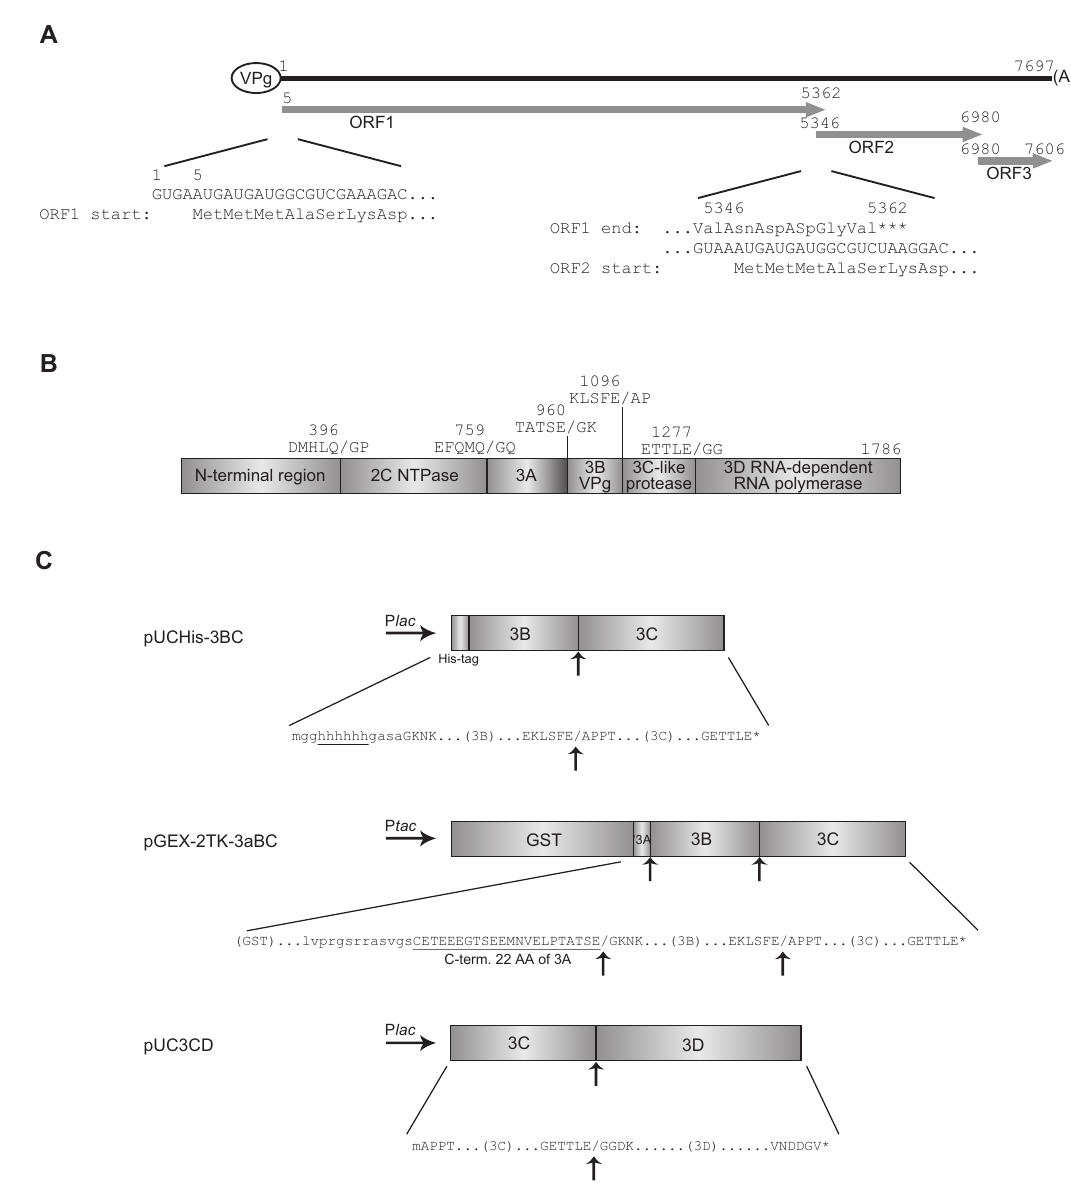
Figure 1 Schematic representation of the norovirus genome and plasmid constructs used for expression in Escherichia coli cells. (A) Genomic organization of the norovirus Chiba strain (GenBank/EMBL/DDBJ ID: AB042808). The RNA genome is 7697 bases in length with its 3 ′ -terminus polyadenylated. The viral protein, VPg, is thought to be covalently linked to its 5 ′ -end. The fi rst 25 nucleotides of the genome are highly homologous to the sequence around the start codon of ORF2. Parts of amino acid sequences of ORF1 and ORF2 are also shown. The end of ORF1 is partly overlapped with the start of ORF2. The numbers indicate the positions of the bases. (B) Proteolytic cleav- age sites found in the ORF1 polyprotein. The numbers indicate the positions of the amino acids. Slashes indicate the cleavage sites recognized by the 3C-like protease. (C) Bacterial expression plasmids frequently used for detection of the proteolytic activity. pUCHis-3BC was used for mutagenesis studies of charged amino acid residues. pGEX-2TK-3aBC was used for the saturation mutagenesis of Glu54, Ala-scanning mutagenesis of neutral residues, and the C-terminal truncation study. pUC3CD was used for examination of the N-terminal truncation. The upward-pointing arrows indicate scissile